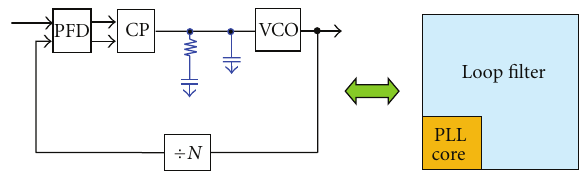
Figure 1: Loop filter area contribution to PLL in advanced CMOS.